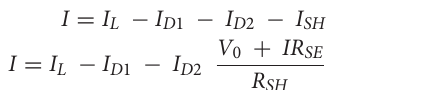
neglect the R SE and R SH resistor in photovoltaic cell